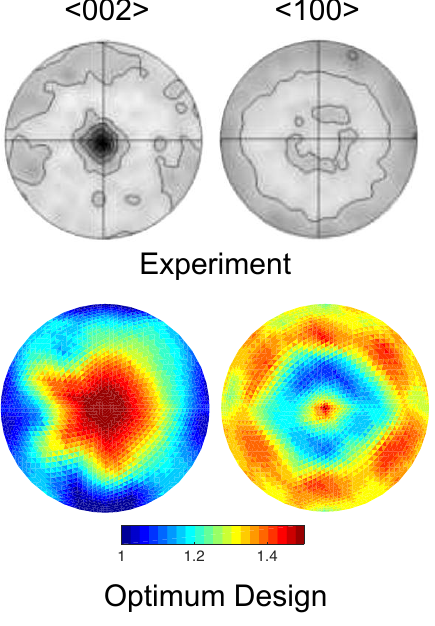
Figure 2. < 002 > and < 100 > PFs at 9% compressive strain (Experimental data is given by Fitzner